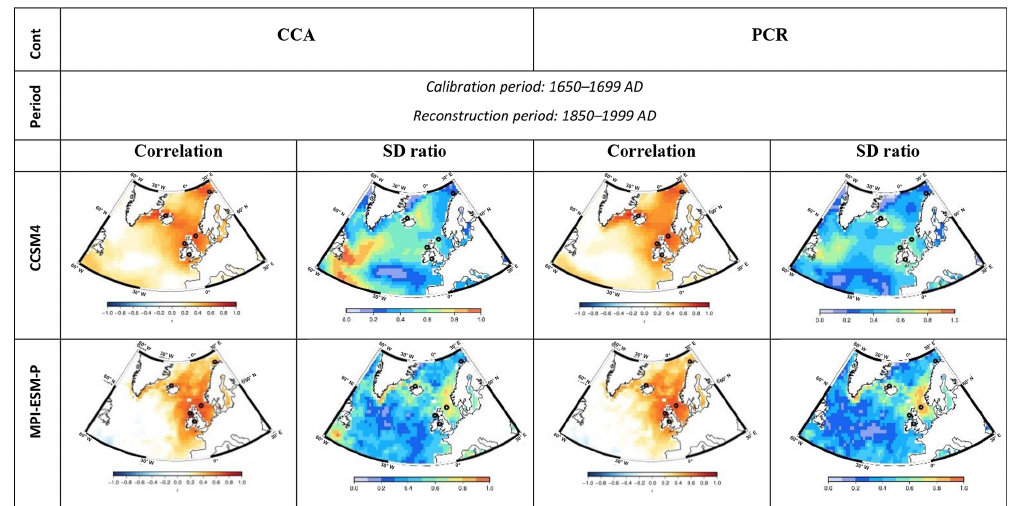
Figure 4. Same as in Fig. 2 but for the noise-contaminated pseudo-proxies.